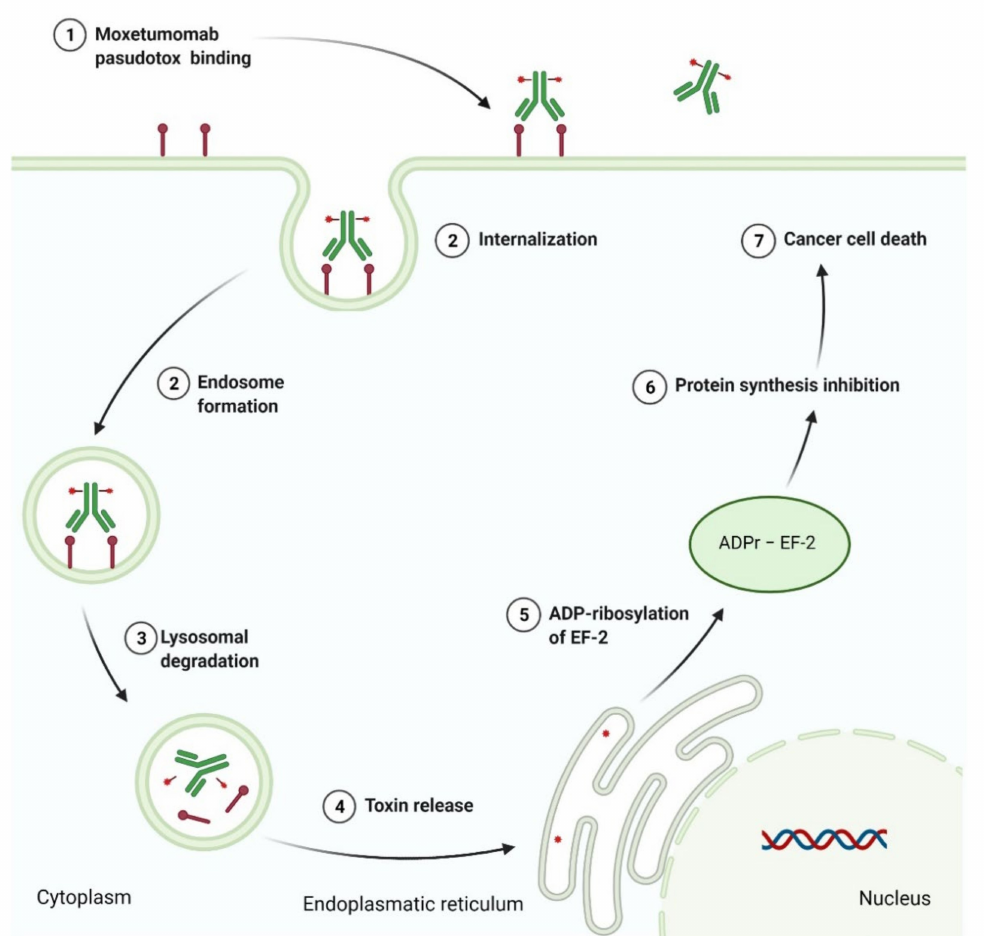
Figure 12. Intoxication of cell by moxetumomab pasudotox. ADP : adenosine diphosphate. ADPr : adenosine diphosphate ribose. EF-2 : elongation factor-2. Figure based on the following reference [275]. Adapted from “Intracellular layout—endocytosis pathway,” by BioRender.com (2021). Retrieved from https://app.biorender.com/biorender-templates (accessed on: 8 December